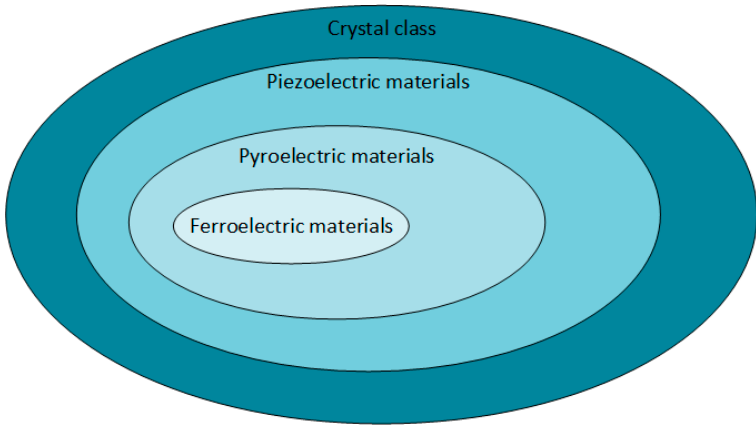
Figure 4. The relationship between piezo-, pyro-, and ferroelectric materials.